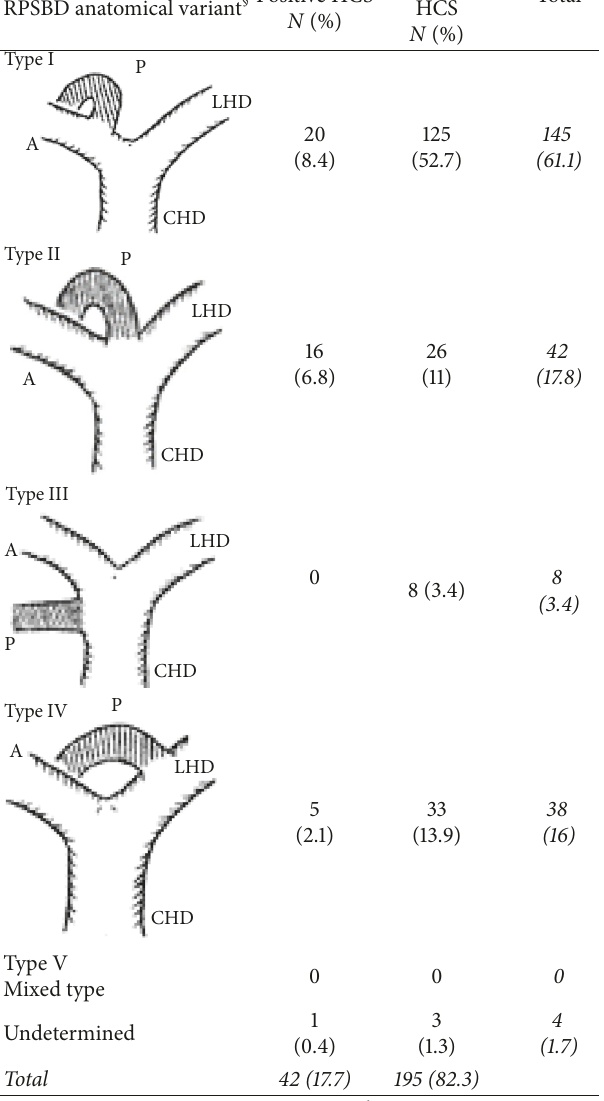
RPSBD: Right Posterior Sectional Bile Duct. § Nakamura ’s classification of RPSBD. LHD: left hepatic duct. CHD: common hepatic duct. A: Right Anterior Sectional Bile Duct. P: Right Posterior Sectional Bile Duct. N : number. HCS: Hjortsjo Crook Sign. Data are frequency counts (percentage of